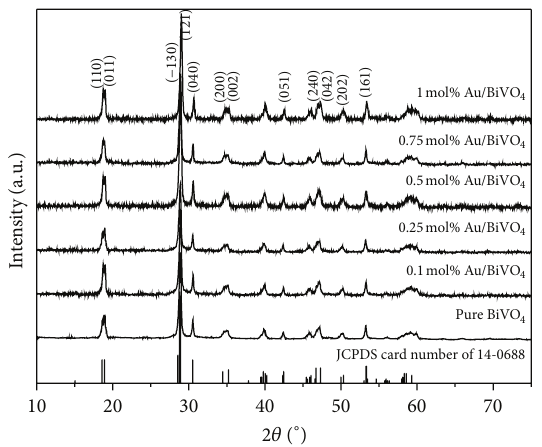
Figure 1: XRD patterns of pure BiVO 4 and Au/BiVO 4 with different Au loading amounts.